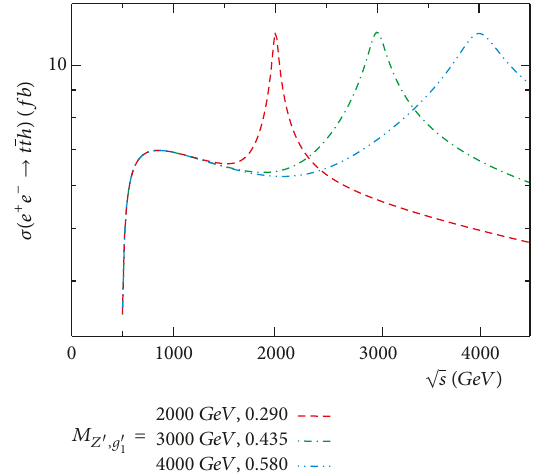
Figure 4: The total cross section of the production process 𝑒 + 𝑒 − 󳨀→ 𝑡𝑡ℎ as a function of √𝑠 . The curves are for 𝑀 𝑔 耠 = 0.290 , 𝑀 = 3000 𝐺𝑒𝑉 and 𝑔 耠 푍 󸀠 1 and 𝑔 耠 1 = 0.580 ,